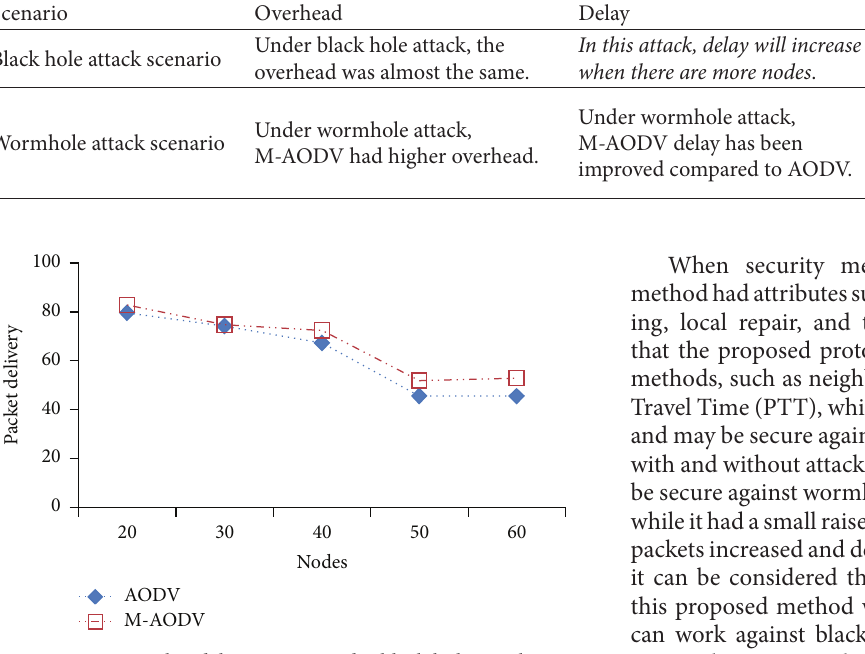
Figure 11: Packet delivery ratio under black hole attack.